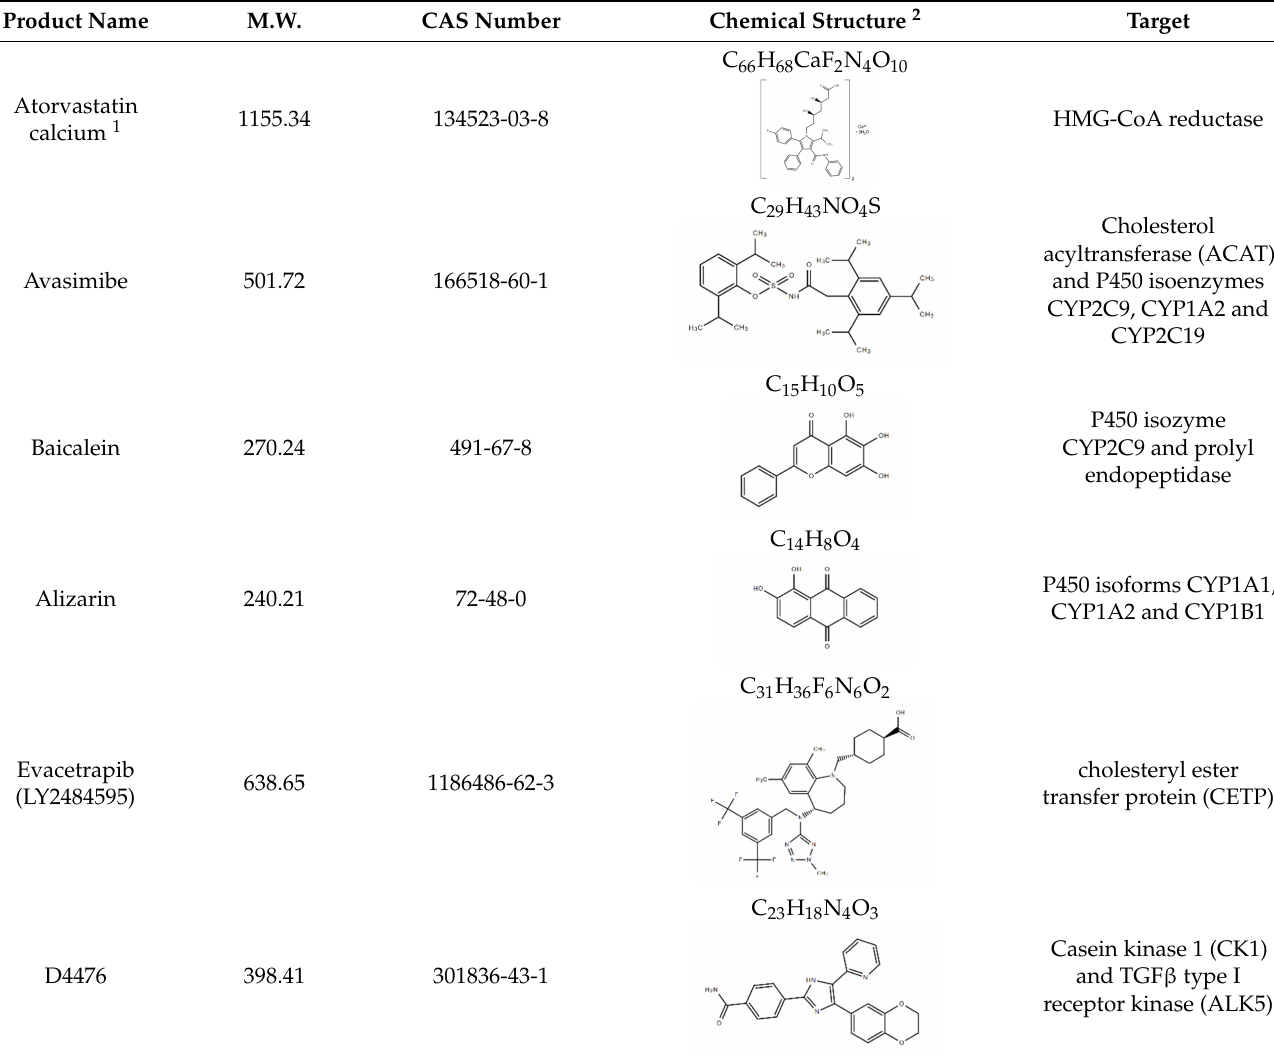
Table 1. A list of potential drug candidates screened from 96 small-molecule inhibitors that resulted in more than 50% reduction in fluorescence intensity compared to the control in the aptamer-based competitive drug screening